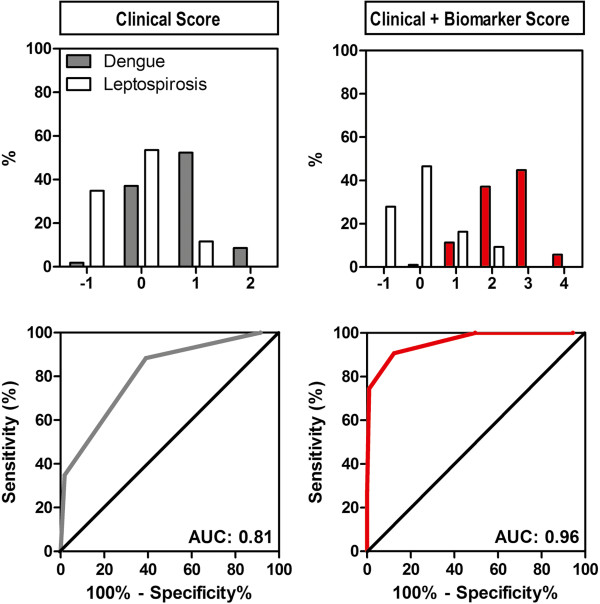
Integrating Biomarker Data into a Clinical Score Improves Diagnosis of Dengue Fever. A clinical score (from -1 to 2) was created for each study participant by assigning a value of 0 (not present), -1 (more common in leptospirosis) or +1 (more common in dengue) for leukopenia, rash and dizziness. The score was used to create an area under the ROC curve (AUC) of 0.81 (95% CI, 0.73-0.86), p < 0.001. Biomarker data were then integrated into the clinical score (from -1 to 4) by assigning a value of +1 if IL-18BP (>24.5 ng/mL) and sEng (> 9.12 ng/mL) levels were higher than the assigned cut-offs to generate an AUC of 0.96 (95% CI, 0.91-0.98), p < 0.001.